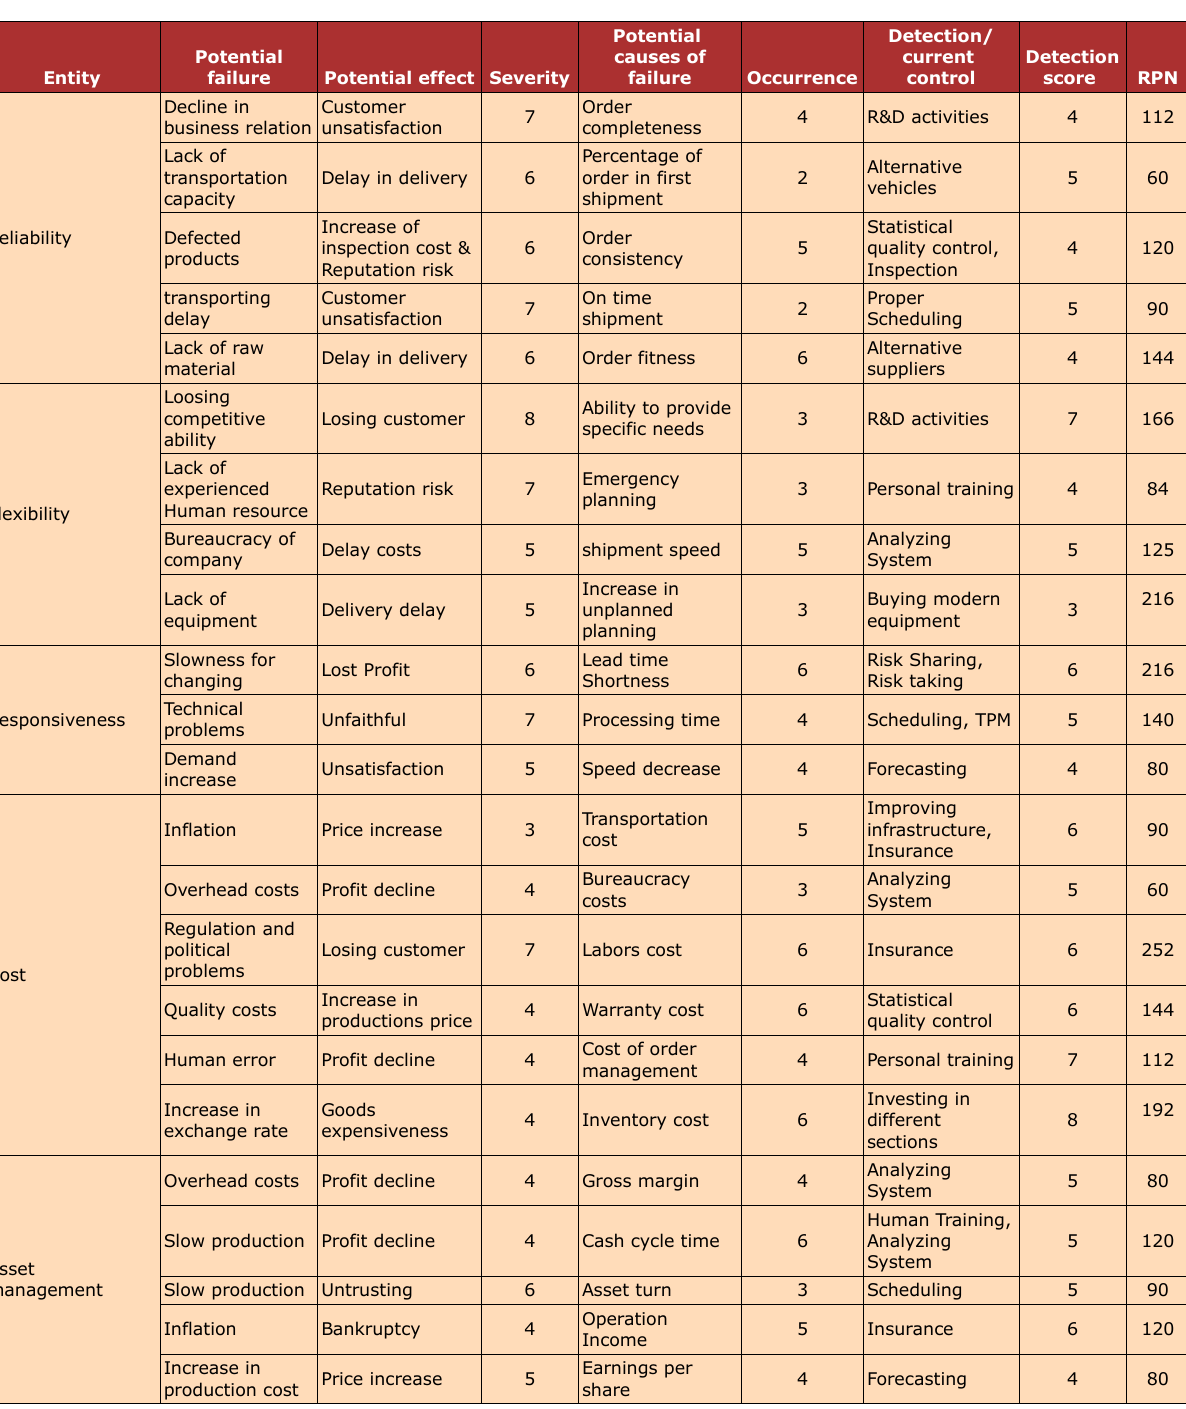
Table 2. Application of the FMECA to the supply chain